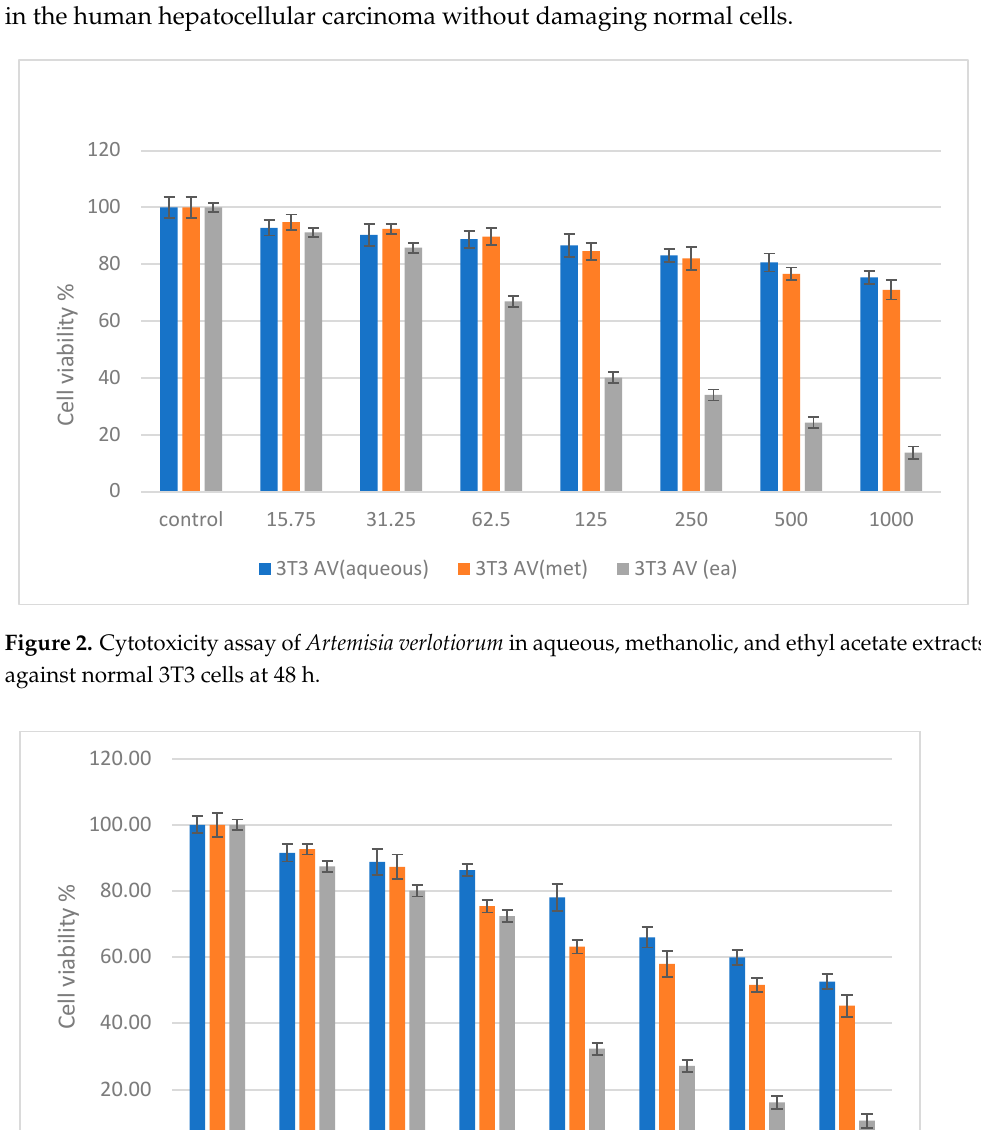
Figure 4. Cytotoxicity assay of Artemisia verlotiorum in aqueous, methanolic, and ethyl acetate extracts against human colorectal carcinoma HT29 cells at 48 h. 3. Discussion Despite being poorly studied, Artemisia verlotorium Lamotte is employed in traditional medicine in different countries such as Italy, Mauritius, and Brazil. Its infusion is administered as a remedy against hypertension in Italy [22]. In Mauritius, the plant decoction is recorded to be employed to treat fever, psoriasis, and influenza [23]. In Brazil, the inhabitants value the medicinal properties of this species against diseases related to circulatory, digestive, genito-urinary, and respiratory disorders [24]. To the best of our knowledge, this is the first report investigating the phytochemical and biological profile of A. verlotiorum . To understand the biological activities that plant species exert, it is important to evaluate and explore their phytochemical constituents. The phytochemical evaluation in this study was performed by first evaluating the total phenolic, flavonoid, phenolic acid, and flavonol content of the A. verlotorium extracts. Based on the amount of extracted